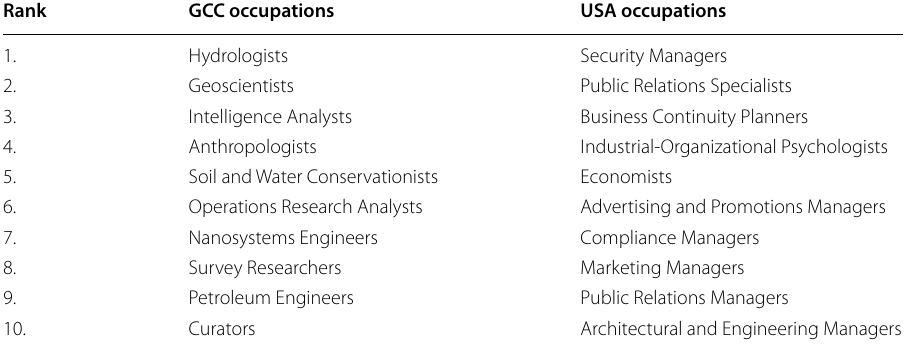
Table 4 Top 10 GCC (left) and USA (right) oil & gas Occupations(LDA model) Rank GCC